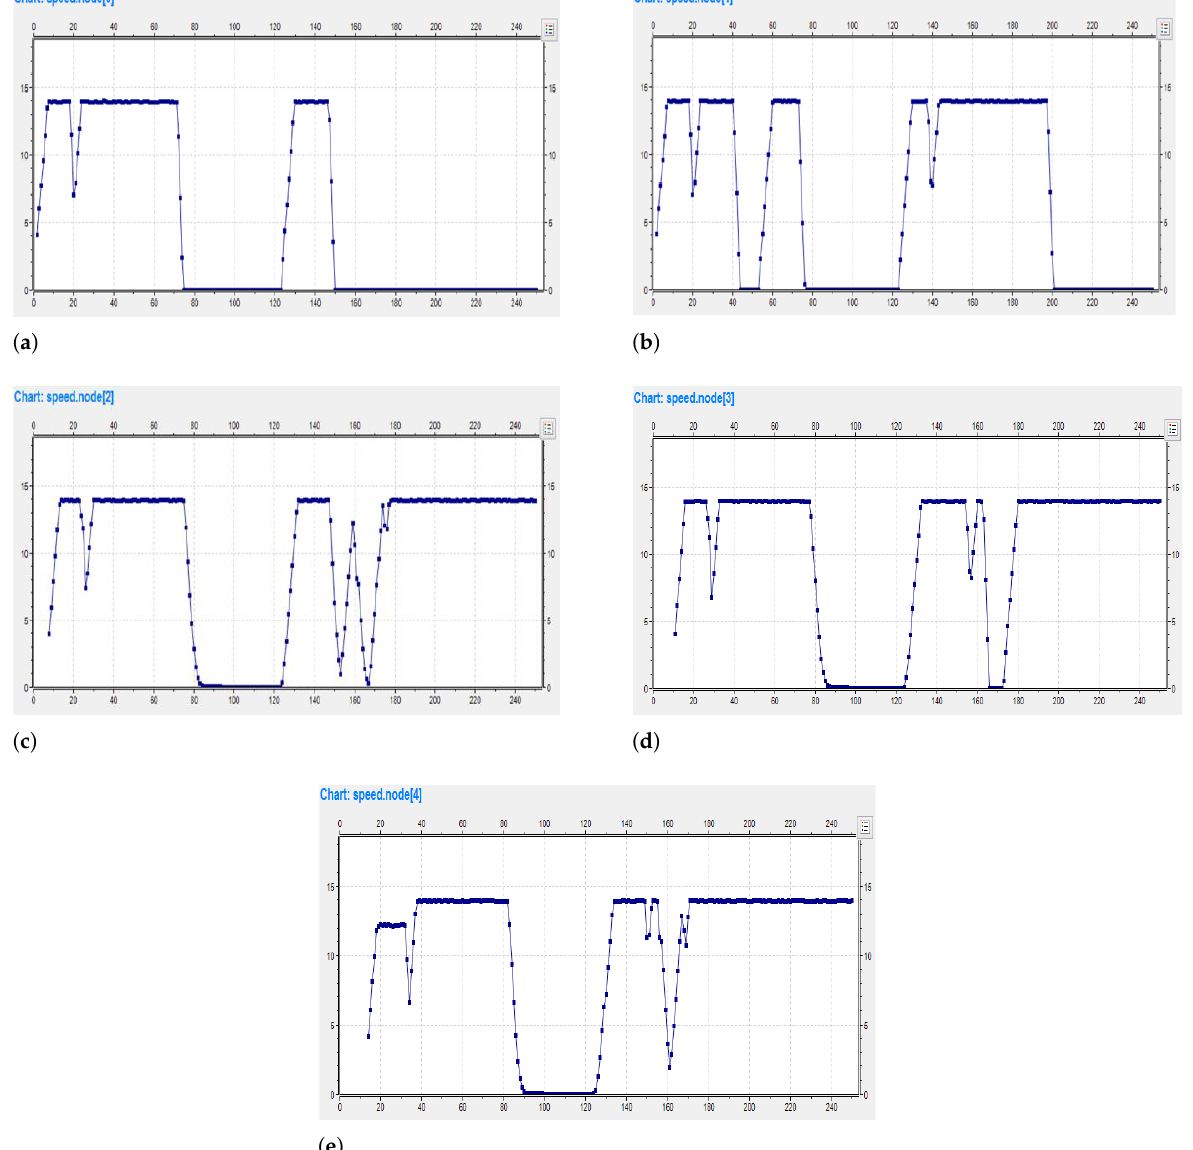
Figure 10. Speed graphs of Vehicles. ( a ) Vehicle 0 Speed; ( b ) Vehicle 1 Speed; ( c ) Vehicle 2 Speed; ( d ) Vehicle 3 Speed; ( e ) Vehicle 4